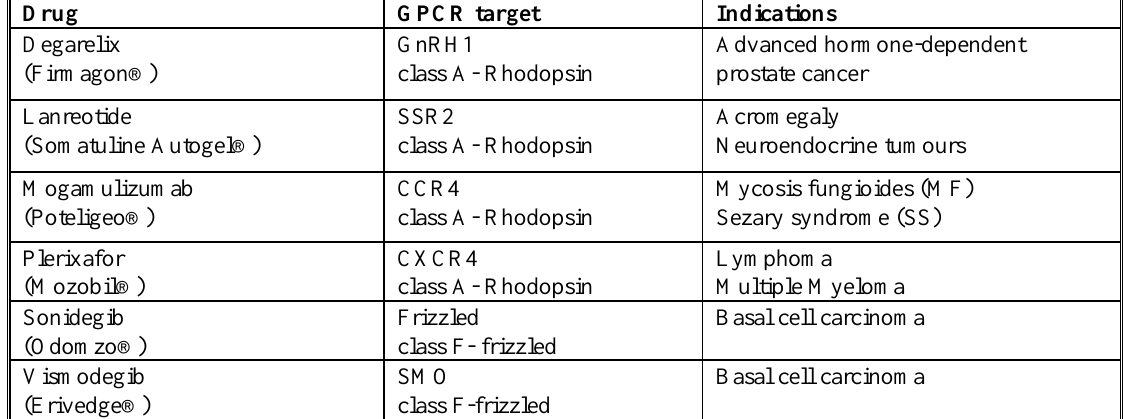
Table 3. Drugs targeting G protein-coupled receptors (GPCRs) for the treatment of cancer (111,114,115)